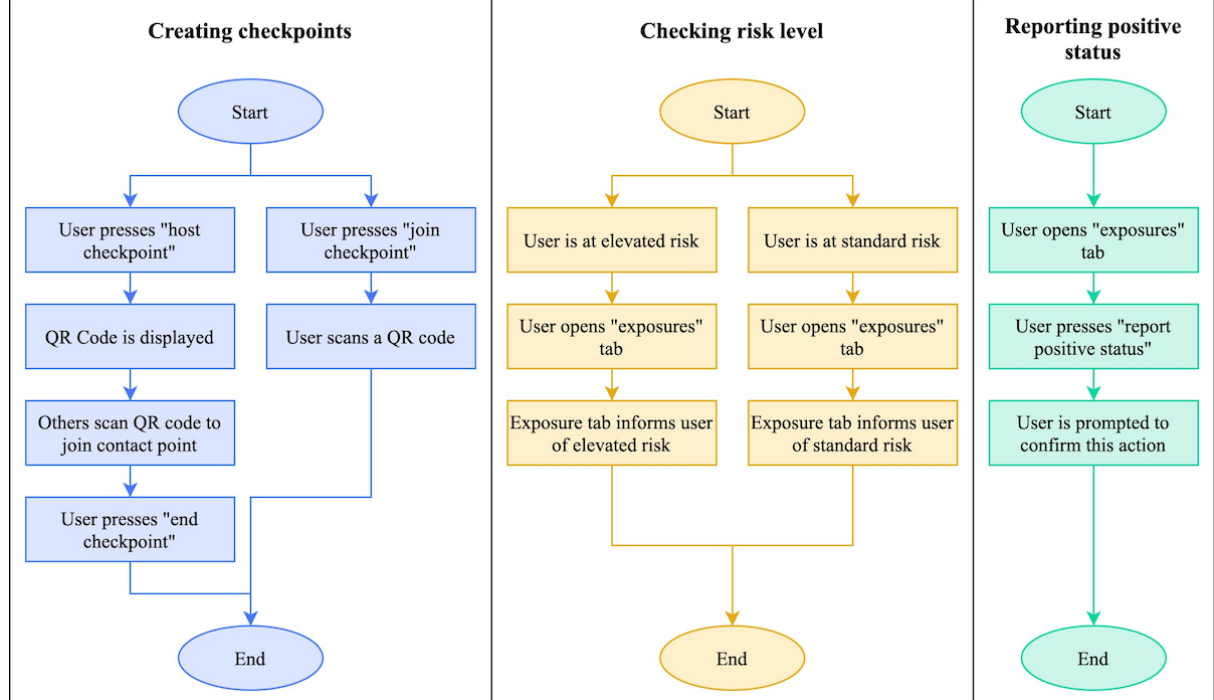
Figure 2. User flow diagrams for the three primary user flows in the peer-to-peer contact tracing app: creating checkpoints, checking risk, and reporting positive status. QR: Quick